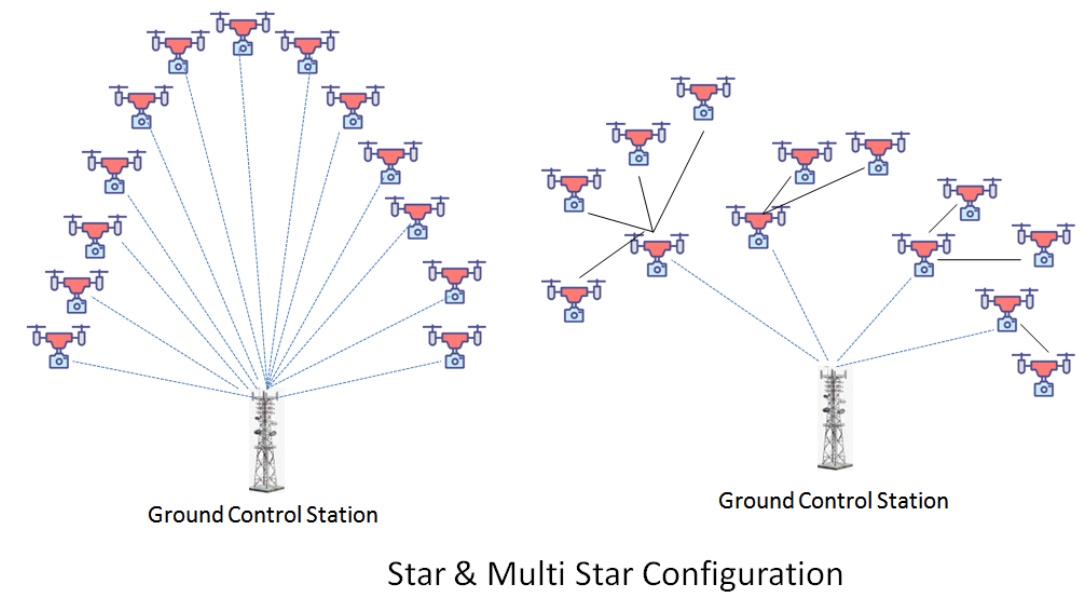
Figure 6. UAVs wireless mesh networks.